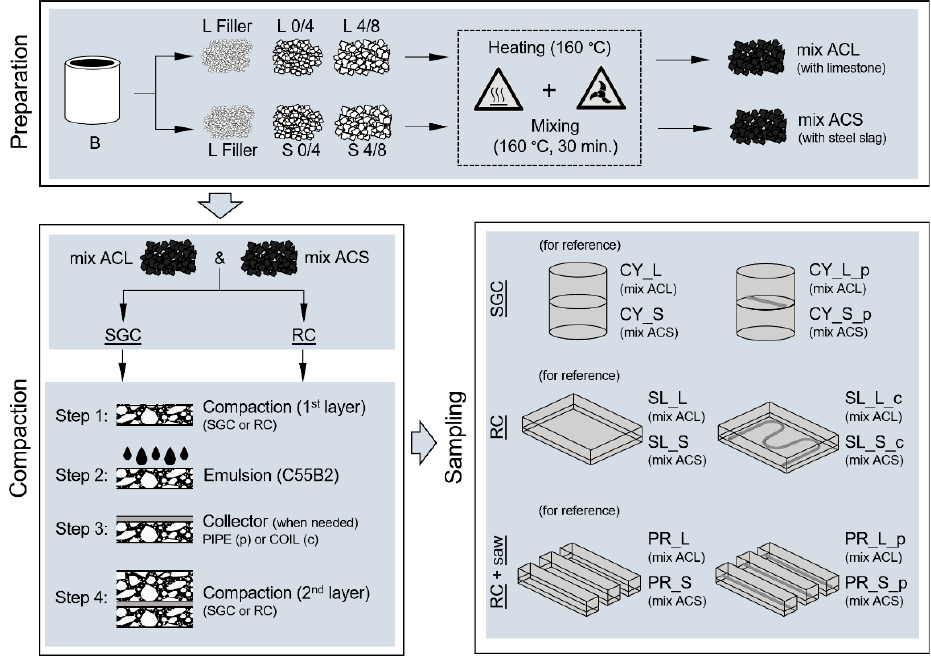
Figure 5. Flowchart of mixtures’ production, compaction, and sampling.